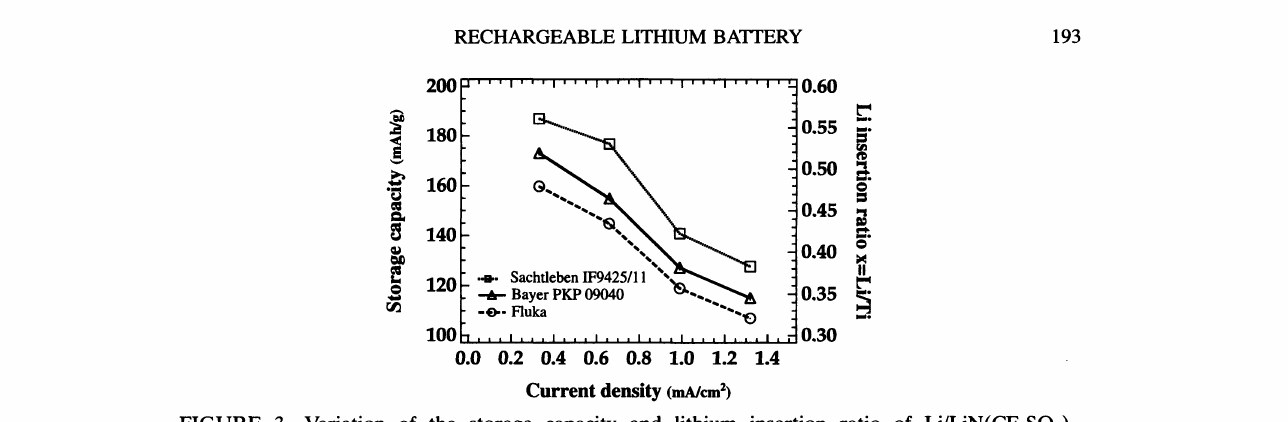
FIGURE 3 Variation of the storage capacity and lithium insertion ratio of Li/LiN(CF3SO2)2, EC:DME/TiO2 cells with current density for different anatase materials.